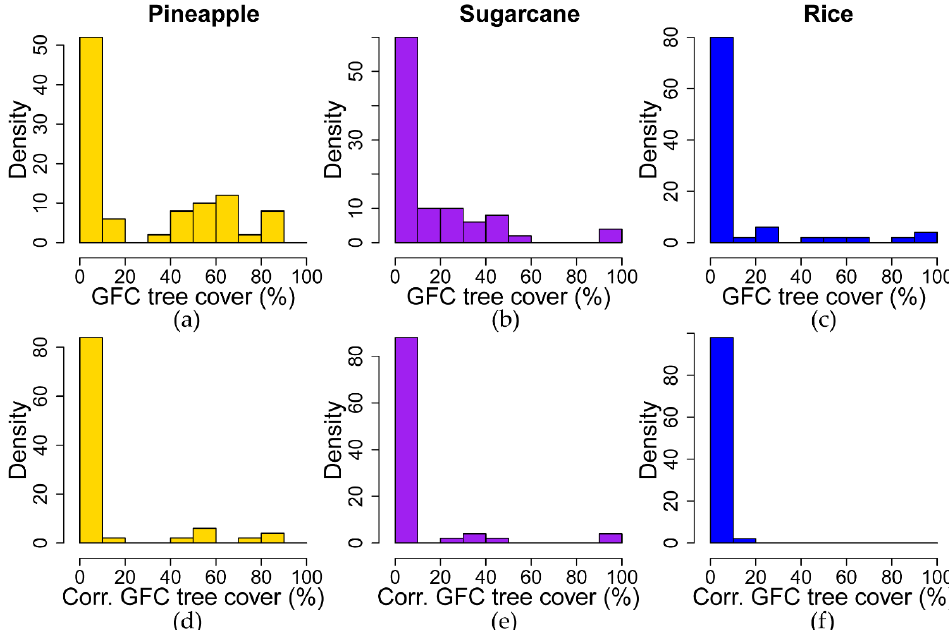
Figure 5. Panels ( a – f ) compare the distribution of tree cover in the GFC and revised forest maps for three agricultural species. These histograms show the estimated 2015 tree cover in pineapple, sugarcane, and rice fields, before and after tree cover was corrected using an agricultural land cover mask. Tree cover percentage is on the x-axis, and the percentage of agricultural training data points (n = 300) in each histogram bin is on the y-axis.